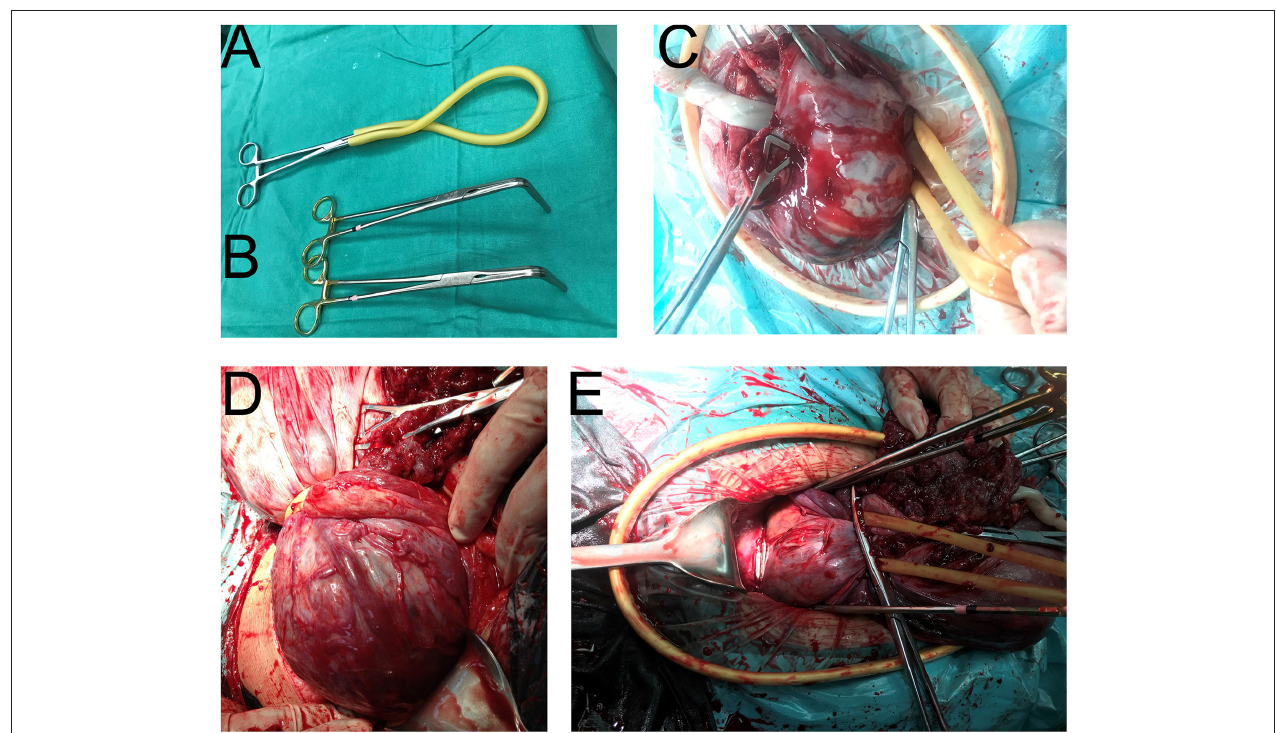
FIGURE 3 | Intraoperative application of our special surgical instruments. (A) The tourniquet (rubber band, No.8). (B) Two bronchus forceps, 15cm. (C) The upper-tourniquet type. All placenta was above the tourniquet. (D) The lower-tourniquet type. Some of the placenta was below the tourniquet. (E) The upper-forceps type. After the application of two forceps, the lower-tourniquet type was converted to the upper-forceps type. The forceps were used to support the placenca and block the blood flow.